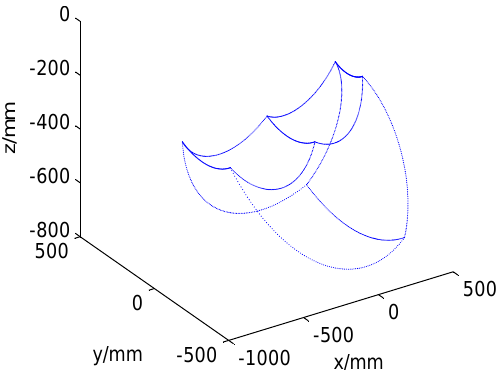
Figure 2. The workspace of the right fore leg of quadruped robot (boundary lines are